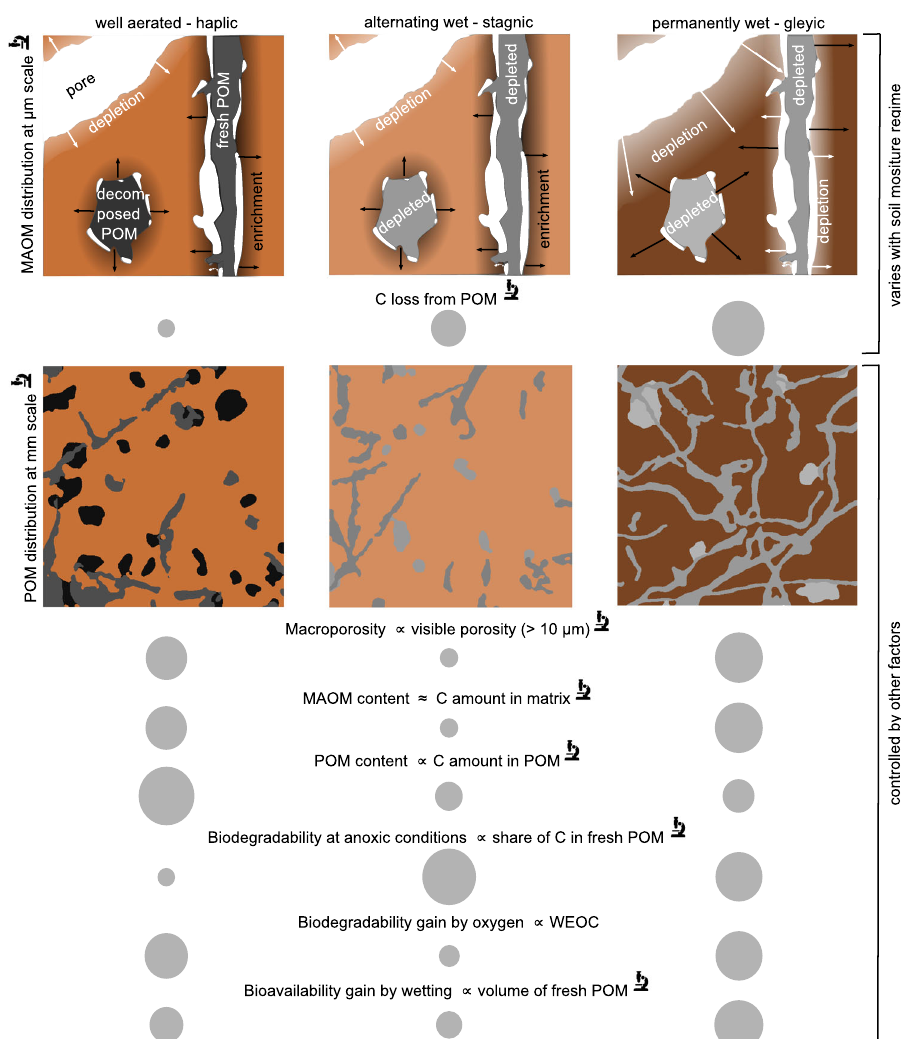
Fig. 8 Synoptic overview on which properties varied with the soil moisture regime. C loss from particulate organic matter (POM) and the redistribution of C in the soil matrix at the µ m scale were mainly (but not exclusively) governed by soil moisture regime. The remaining properties (macroporosity, mineral- associated organic matter (MAOM) and POM content, POM distribution at the mm scale, bioavailability, and biodegradability) were in fl uenced by other factors, among them mineralogy, land use, and productivity. The size of gray circles represents the magnitude of macroscale properties. Morphological POM types are interpreted towards the decomposition stage (fresh, decomposed). Different shades of brown and gray represent C contents in MAOM and POM, respectively. The microscopy icon, / , and (cid:2) represents image-derived properties, “ proportional ” and “ approximately ” ,